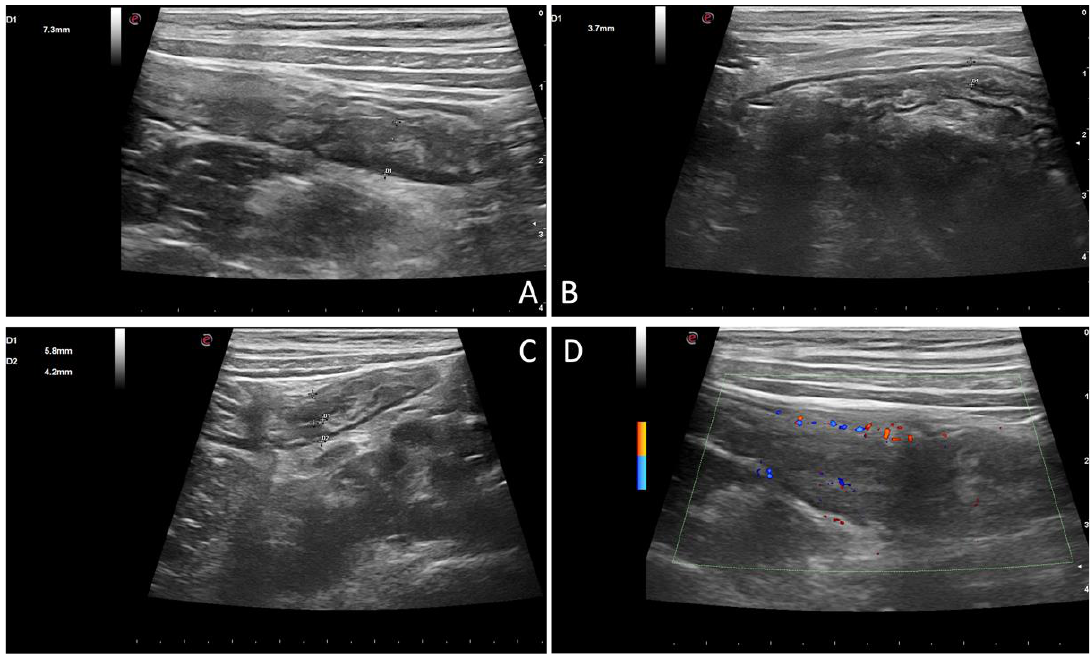
Figure 3. US findings in patient 1. US at diagnosis: increased BWT at colon level ( A ), ileum level ( B ), and ascending colon level ( C ). Increase in power Doppler signaling at colon level ( D ).